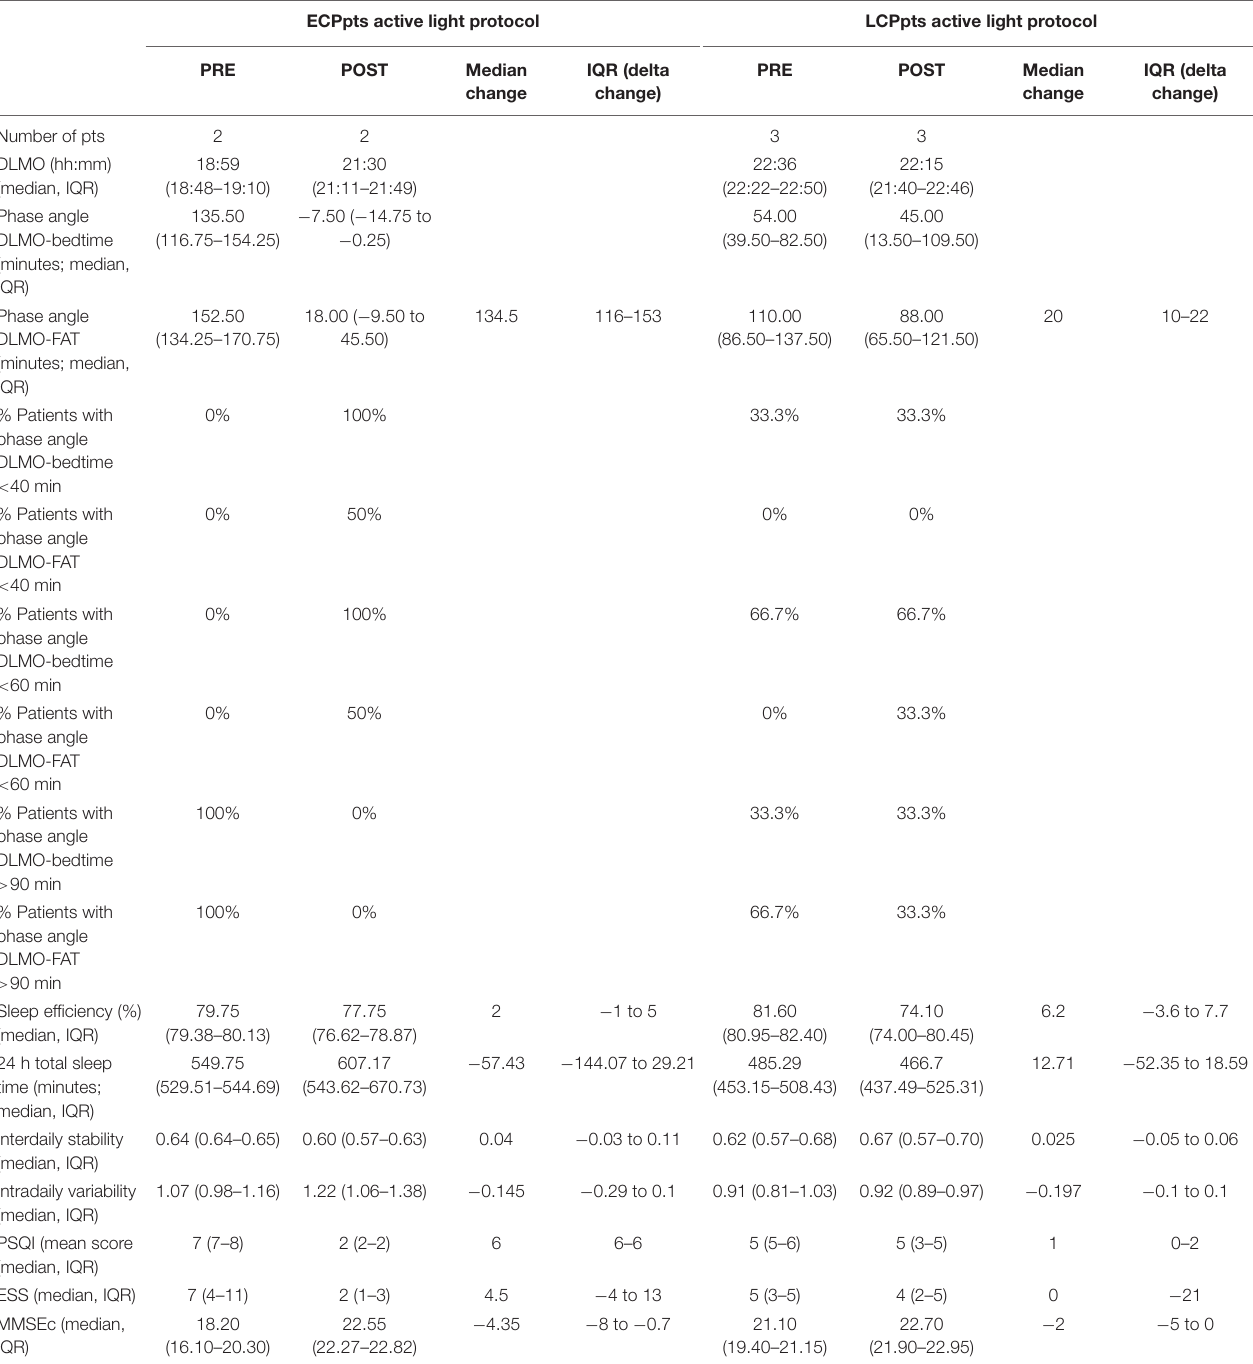
TABLE 2 | Primary and secondary outcomes, and other circadian parameters about the subgroups of both Early Circadian Phase patients (ECPpts) and Late Circadian Phase patients (LCPpts) before (PRE) and after (POST) active light protocol. ECPpts active light